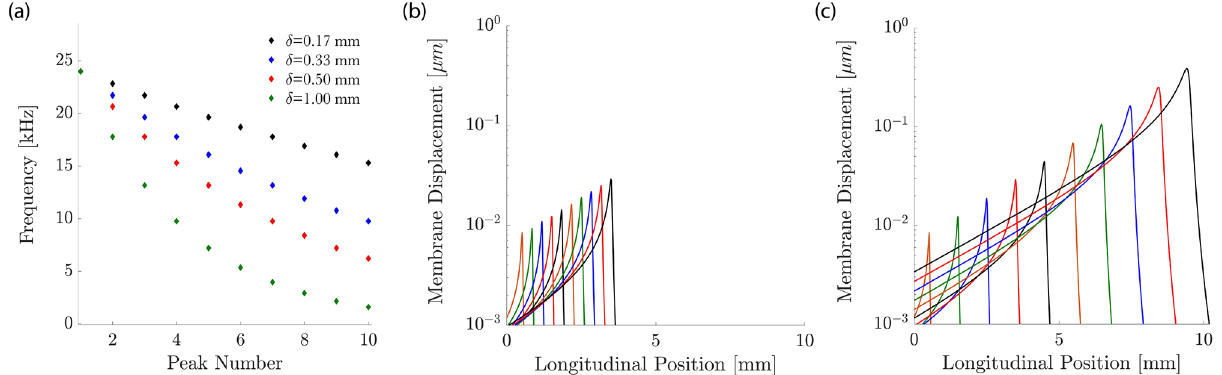
Figure 5. Multi-frequency stimulation. ( a ) We choose discrete frequencies so that successive frequencies differ by a constant ratio, leading to a constant spacing δ of the peaks of the different induced basilar-membrane waves. ( b ) When the frequencies are close such that the spacing between the peaks of the induced waves is small, 330 µ m , we obtain significant overlap between the amplitudes of the individual waves. ( c ) A larger spacing δ = 1 mm , leads to less between the successive peaks, δ =